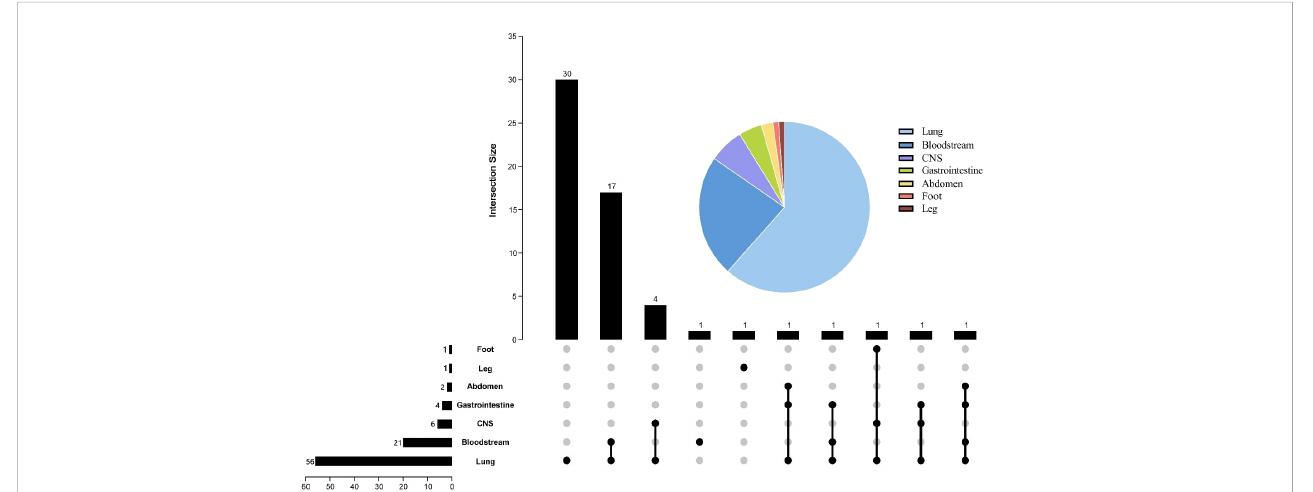
FIGURE 2 Pie and Upset charts of the distribution of infection sites. The pie chart in the upper right corner represents the percentage distribution of each infection site. In the Upset diagram, the rows represent the site of infection, and the number in front of each row indicates the total number of cases of infection at that site; the columns indicate the number of cases for each condition, and the number at the beginning of each column indicates the case of infection at the location of the “ black dot ” ; the black dots connected by lines indicate the presence of multiple infections. CNS, central nervous